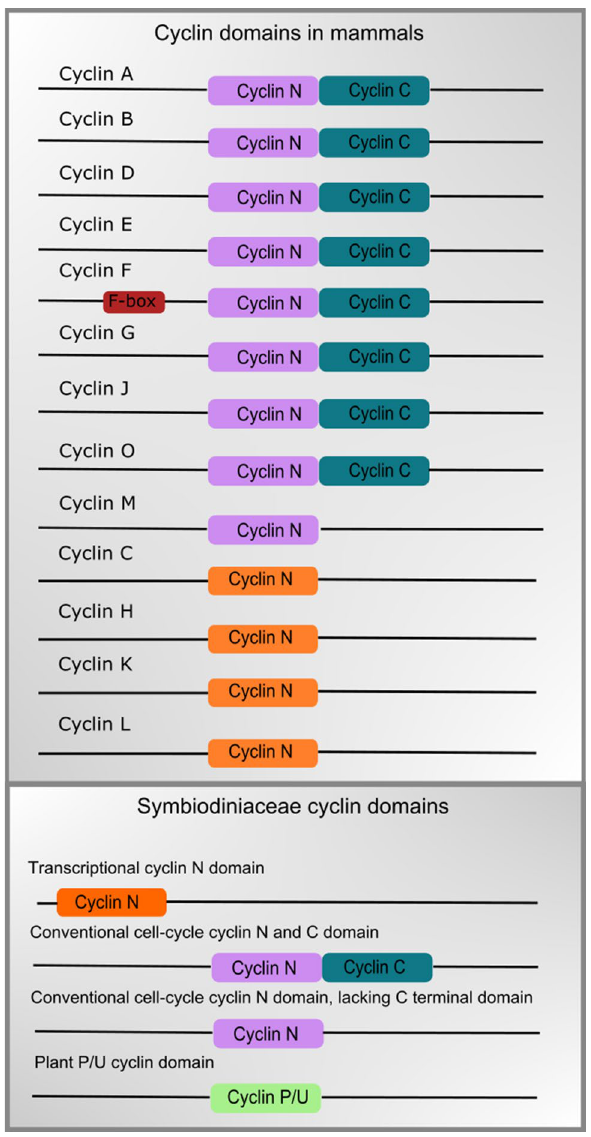
Figure 5. Domain structure of cyclin proteins present in the